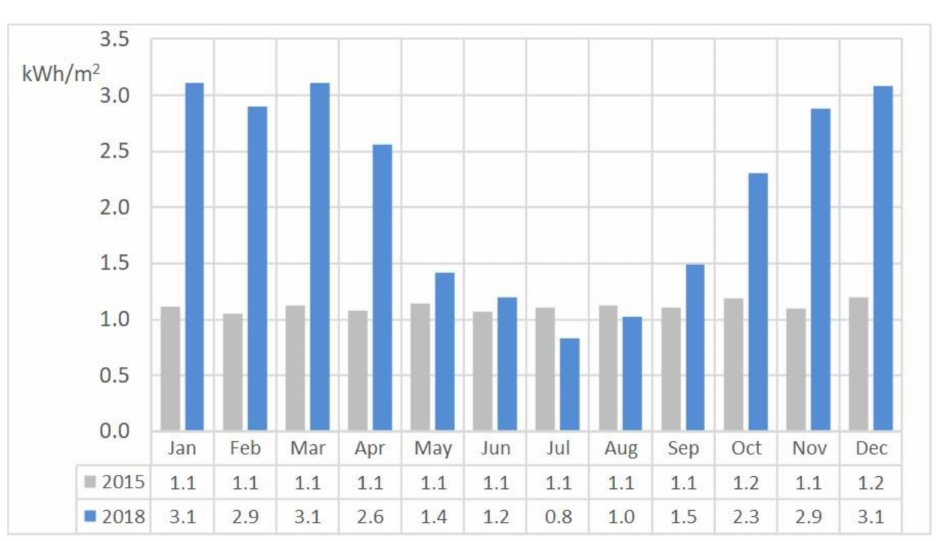
Figure 8. Specific monthly electricity consumption.